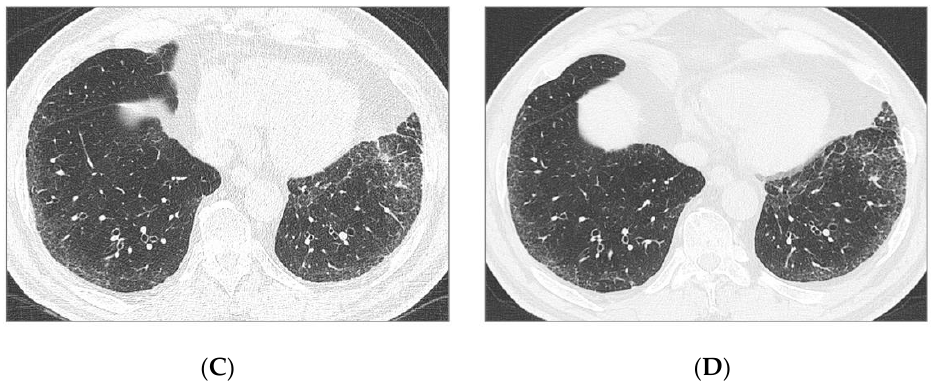
Figure 1. Axial HRCT images of two patients: a 53 year-old male with a progression of disease (patient 1) ( a , b ) and a 63 year-old male with stable disease (patient 2) ( c , d ). Patient 1: HRCT at treatment start ( a ) and after one year of treatment ( b ), demonstrating a significant progression of ground glass opacities and reticulation. Patient 2: HRCT at treatment start ( c ) and after one year of treatment ( d ), demonstrating stability of ground glass opacities and